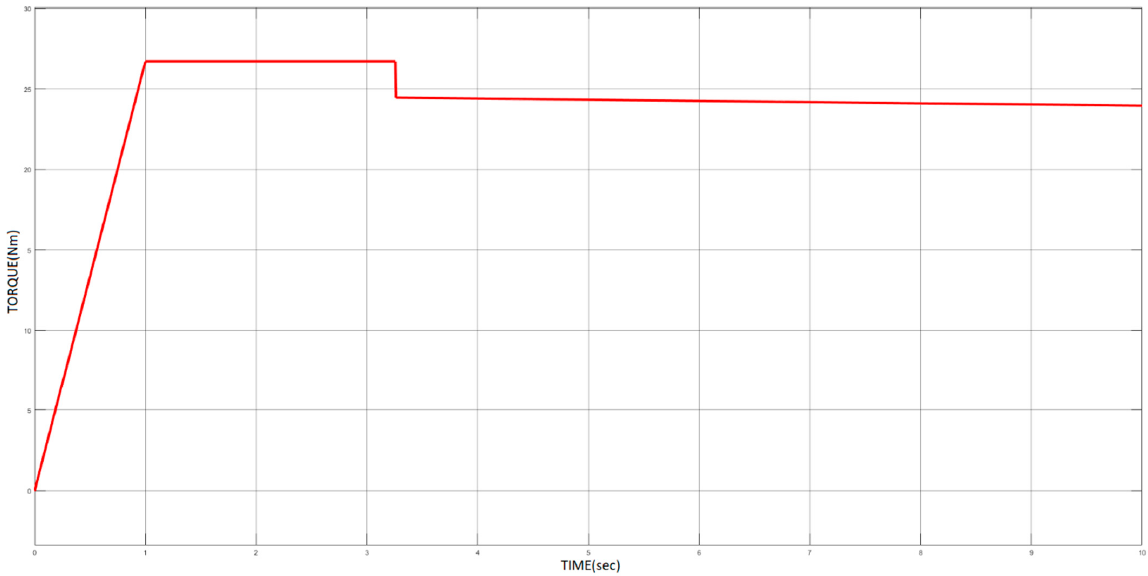
Figure 6. Time series of currents with induced W–N. Additionally, there were simulations with the ramp load torque (Figure 7).